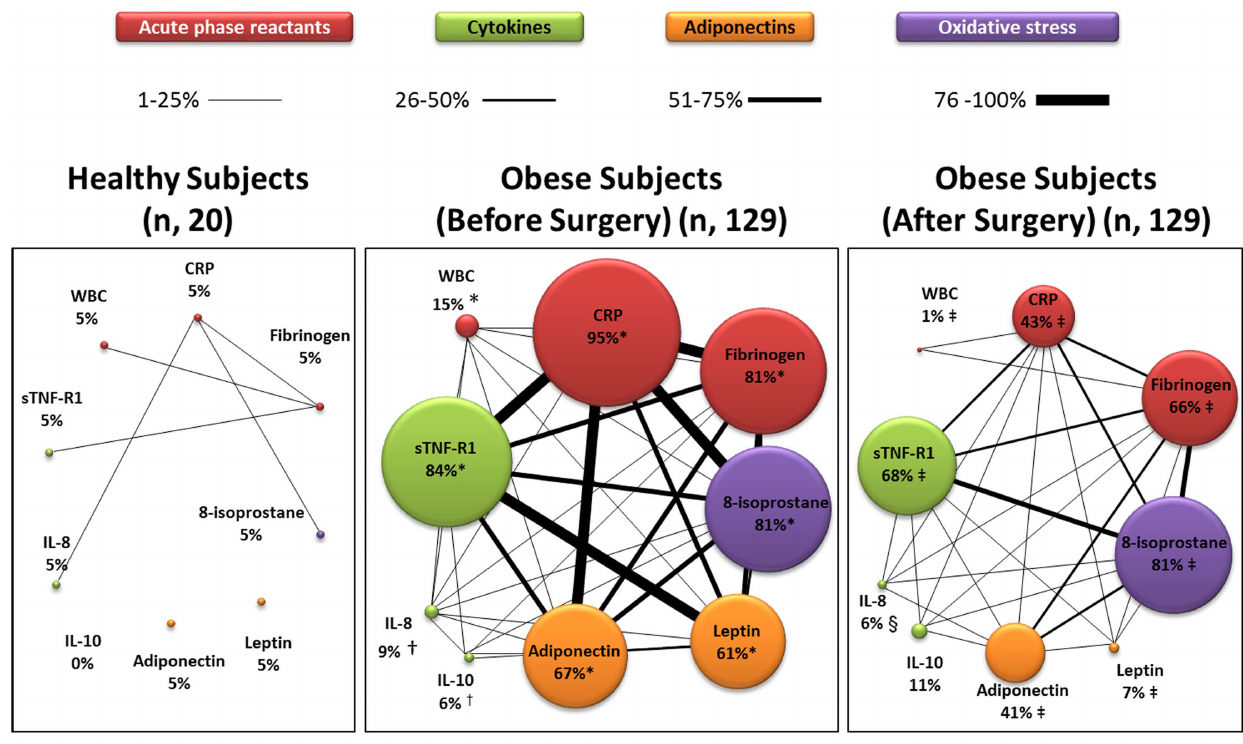
Figure 2. Systemic inflammome in healthy and obese individuals before and after BS. Each node represents one inflammatory marker and color indicates the type of inflammatory marker considered (acute phase reactants, cytokines, adipokines or oxidative stress). The node diameter is proportional to the prevalence of abnormal values (i.e., . 95 th or , 5 th of controls) of that particular biomarker in the population under consideration (control or obese individuals) and the thickness of the edges linking pairs of nodes is proportional to the prevalence of co-occurrence of abnormal biomarkers of that particular pair of nodes. Figure S1 Systemic inflammome in obese participants classified according to sex before BS (for further explanation, see legend to Figure 2). Figure S2 Systemic inflammome in obese participants classified according to smoking habits before BS. Current smokers ( $ 10 pack-years); non- ( , 10 pack-years) or former ( . 1 year after cessation) smokers (for further explanation, see legend to Figure 2). Figure S3 Systemic inflammome in obese participants classified according to the presence or absence of obstructive sleep apnea syndrome (OSAS) before BS. OSAS was define as apnea/hypopnea index . 15 events/hour (for further explanation, see legend of Figure 2). Figure S4 Systemic inflammome in obese participants classified according to the presence or absence of metabolic syndrome (MS) before BS (for further expla- nation, see legend to Figure 2).